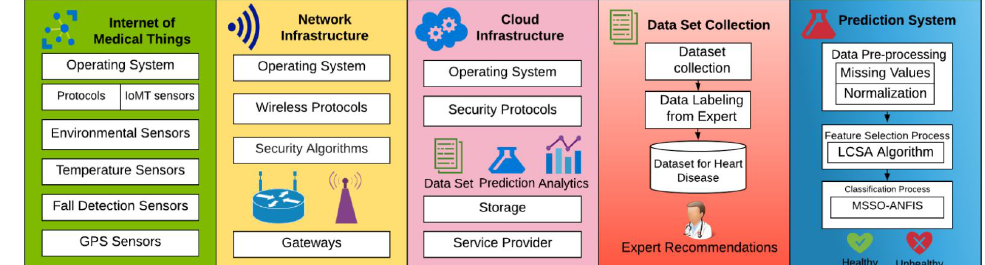
Figure 25. Illustration of the presented health monitoring for detecting heart diseases